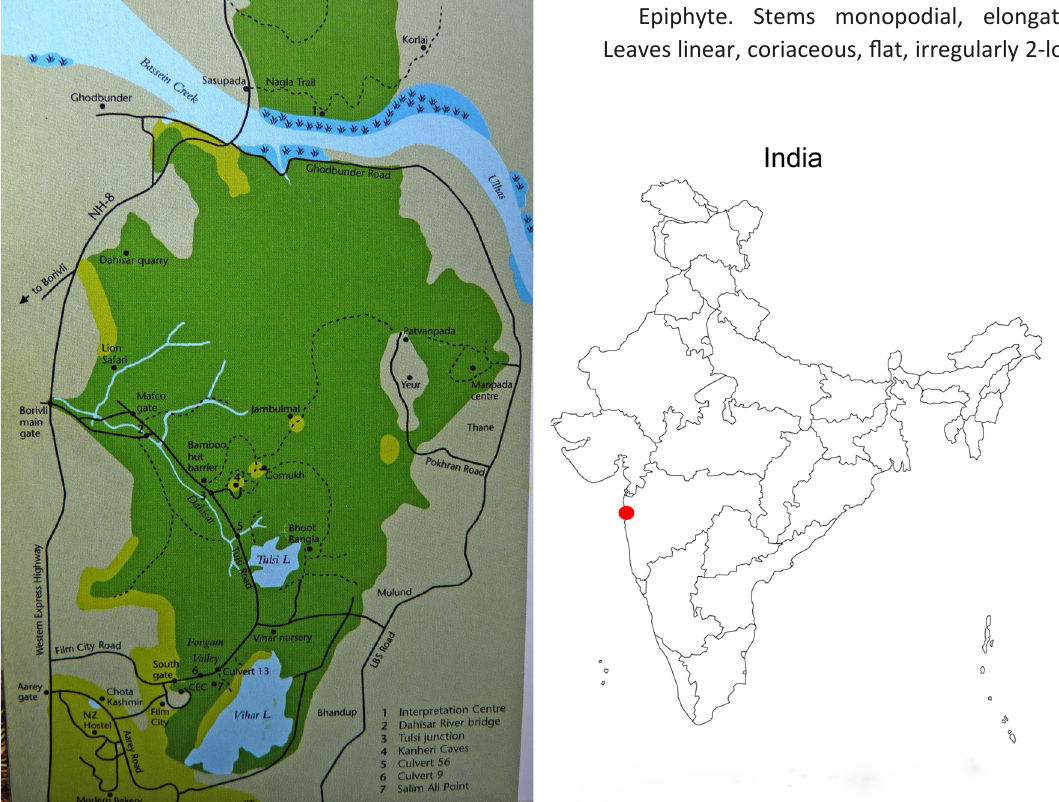
Figure 1. Sanjay Gandhi National Park (© Sunjoy Monga 2003; map not to scale) along with Map of India (©Bruce Jones Design Inc